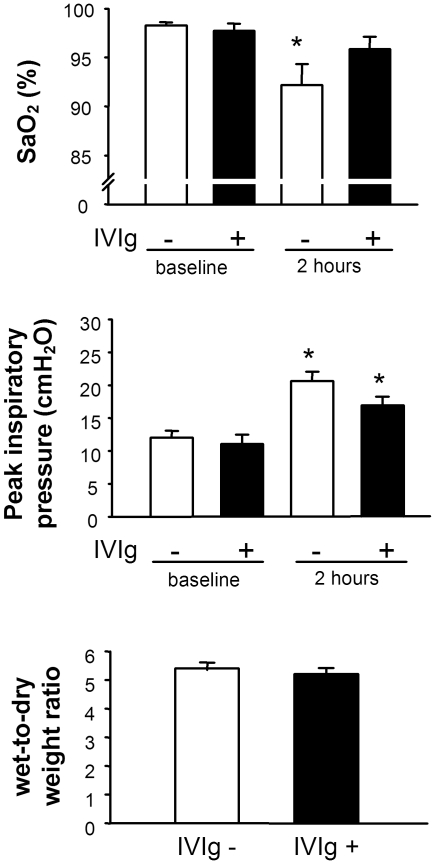
IVIg has a modest protective effect in acid-induced lung injury.IVIg partially protects from arterial hypoxemia, but not changes in lung mechanics and edema formation in acid-induced lung injury. SCID mice were pretreated with either saline (White bars) or 2 g/kg of IVIg (Black bars) 18 hours before acid induced lung injury was induced by intratracheal instillation of HCl (2 mL/kg bw at pH 1.0) (A) Arterial oxygen saturation (SaO2) levels and (B) peak inspiratory pressure were determined at baseline and 2 hours after instillation of HCl. Wet-to-dry lung weight ratios (C) were determined 2 h after HCl instillation. Data are expressed as means±SEM from n = 5 animals in each group. The ★ indicates significance (p<0.05) between baseline and the treatment groups determined by Student's t test.